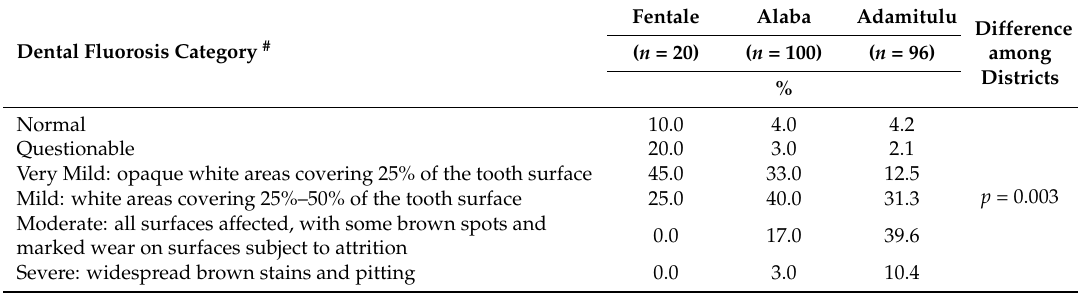
Table 4. Prevalence (%) of dental fluorosis among school age children.